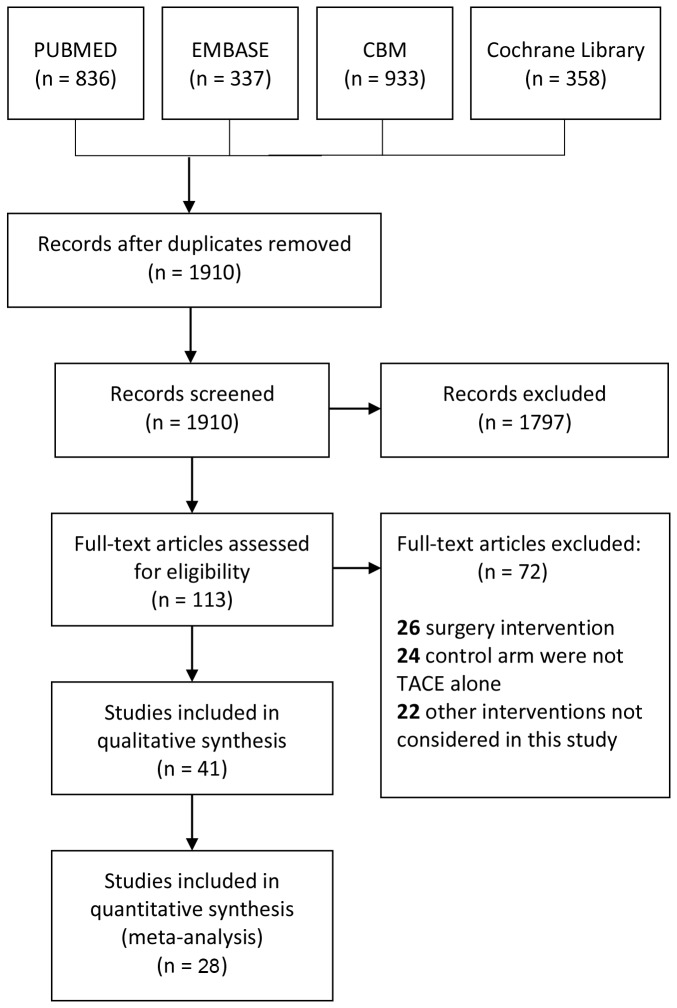
Identification of eligible studies from different databases.